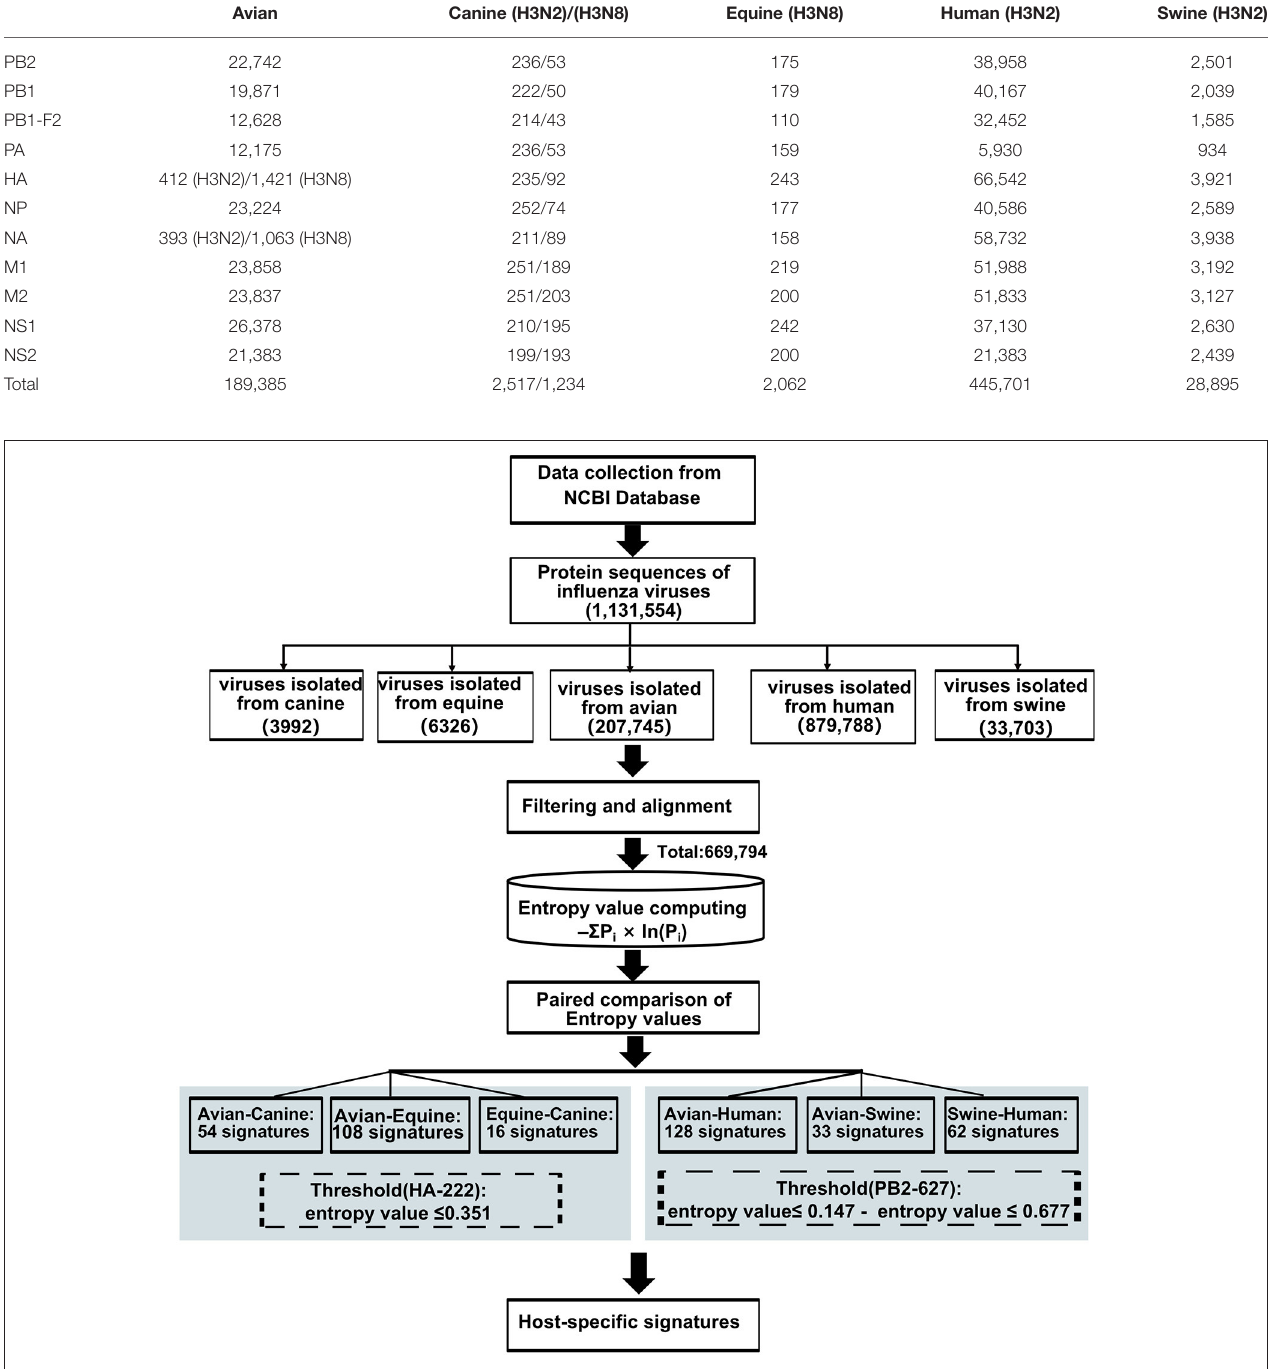
FIGURE 1 | Work flow for predicting host-adaptive signatures.